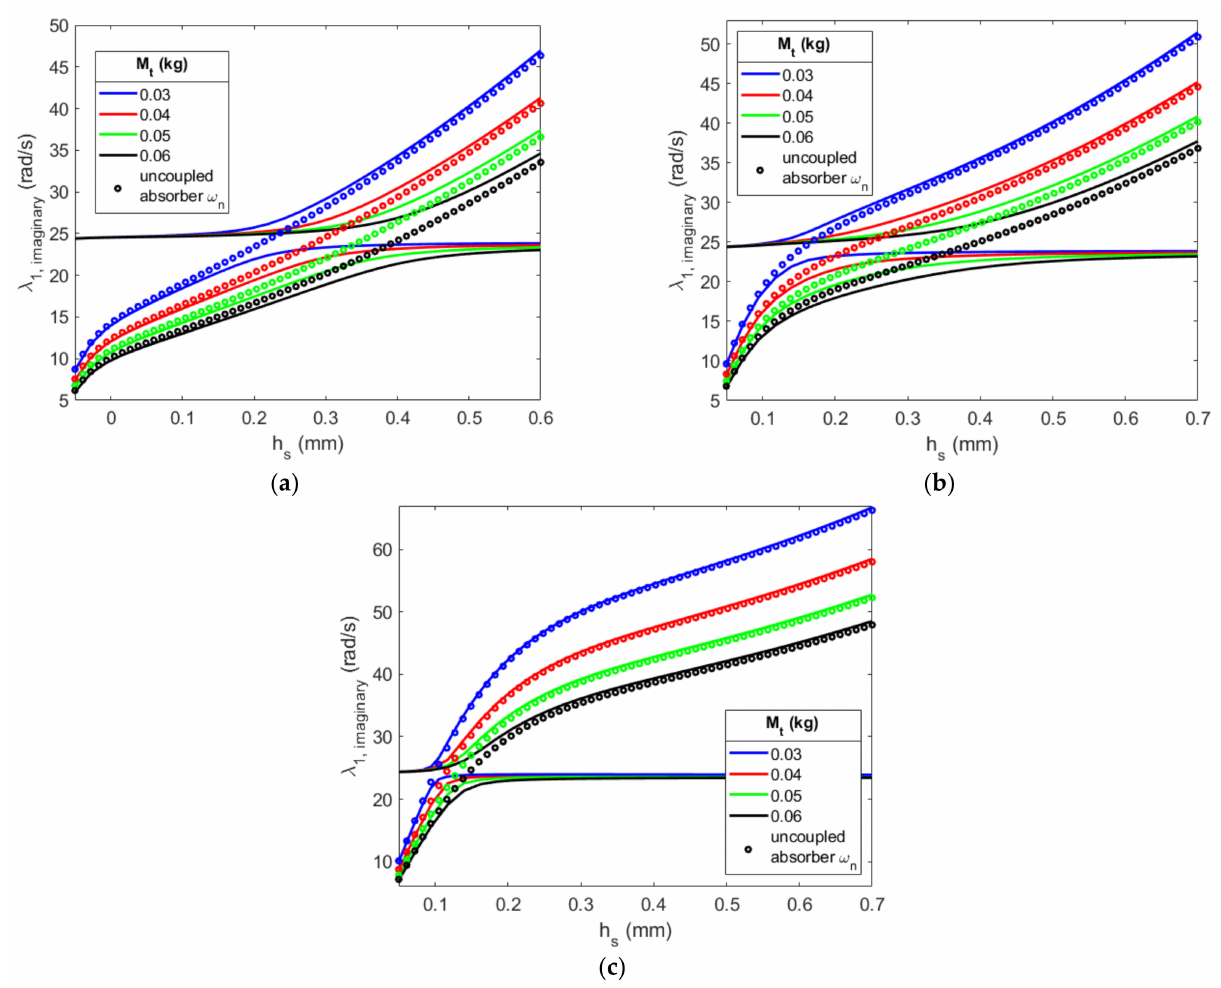
Figure 17. The substrate thickness’s effects on the natural frequencies for varying tip masses for a gap size of ( a ) 10 mm, ( b ) 7.5 mm and ( c ) 5